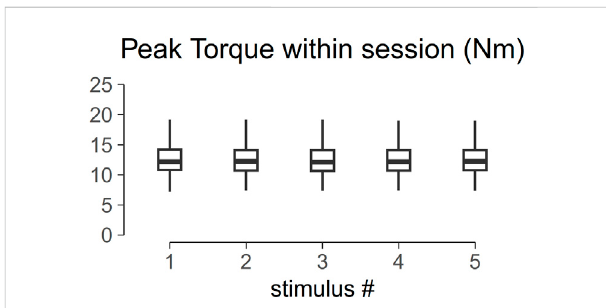
Box plot of the peak torque (PT) within one session. Analysis of varianceshowsnosigni fi cantdifferenceacrosstrialwithinonesession ( p > 0.05).